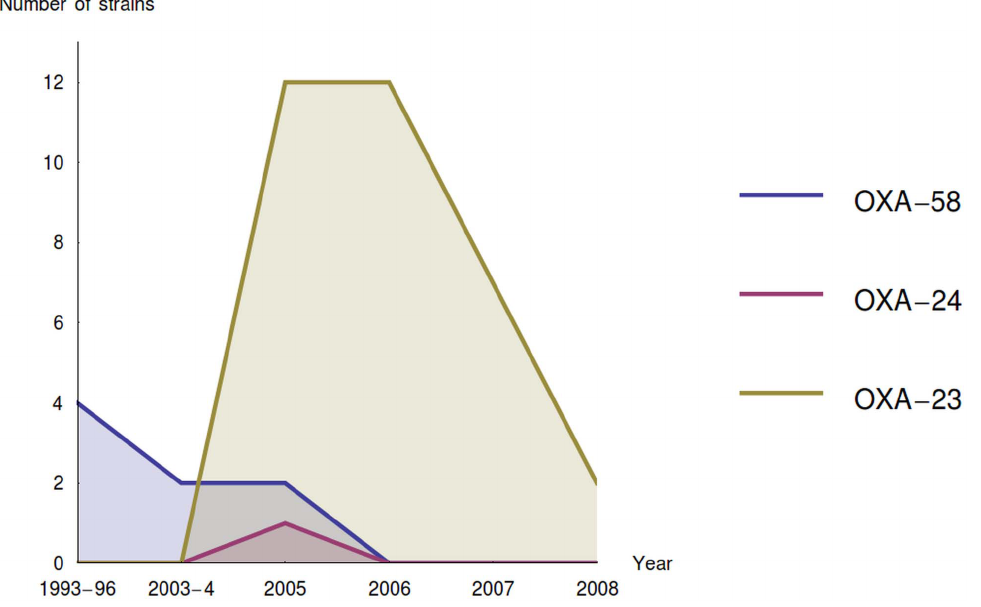
Figure 2. Time-dependent distribution of acquired oxacillinase genes; OXA-23-like, OXA-24-like and OXA-58.